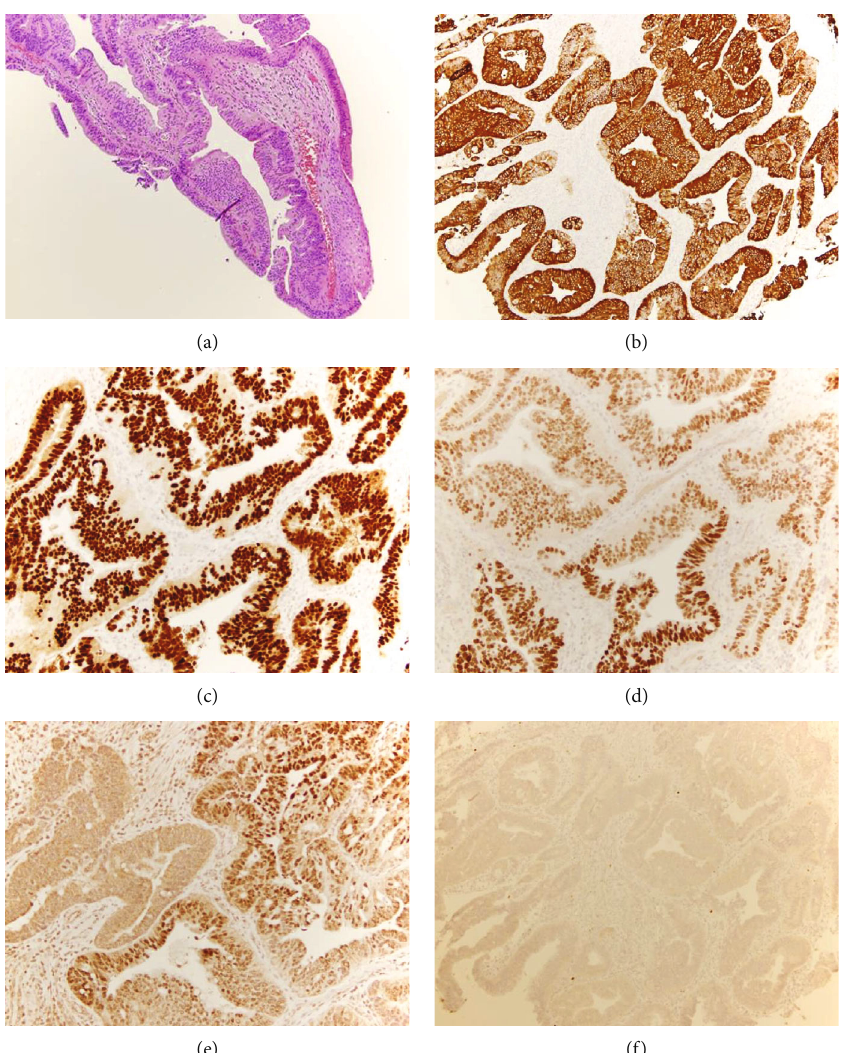
Figure 4: (a) Histologic sections of the urethral biopsy showed intestinal metaplasia of squamous mucosa with transition from a mature to dysplastic phenotype with the adenocarcinoma appearing to originate from the dysplastic intestinal metaplasia. Immunohistochemistry showed positivity for CK20 (b), caudal-type homeobox 2 (CDX2) (c), patchy expression of SAT-B2 (d) and PAX-8 (e), and negative for p16 (f). Magni fi cation in (a), (b), and (f) is 10x and in (c) – (e) is